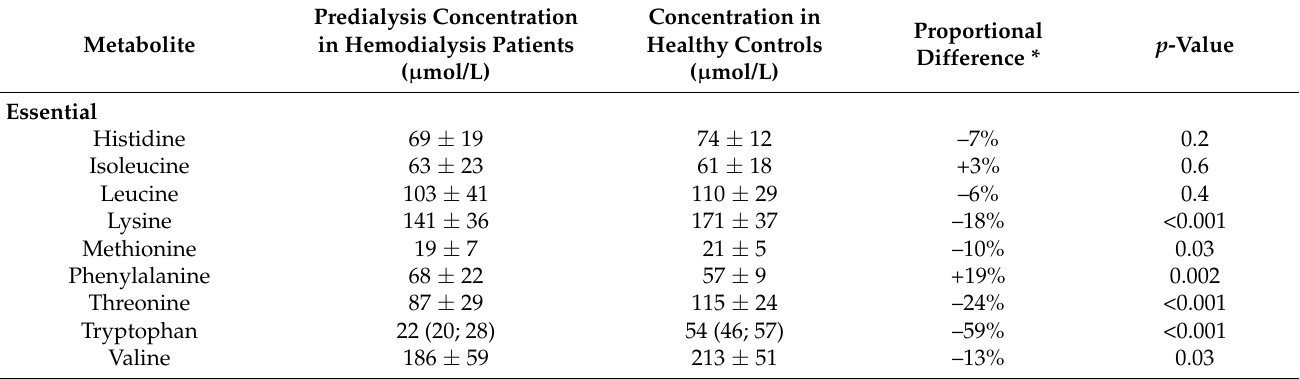
Table 2. Comparison of plasma amino acid concentrations between hemodialysis patients and